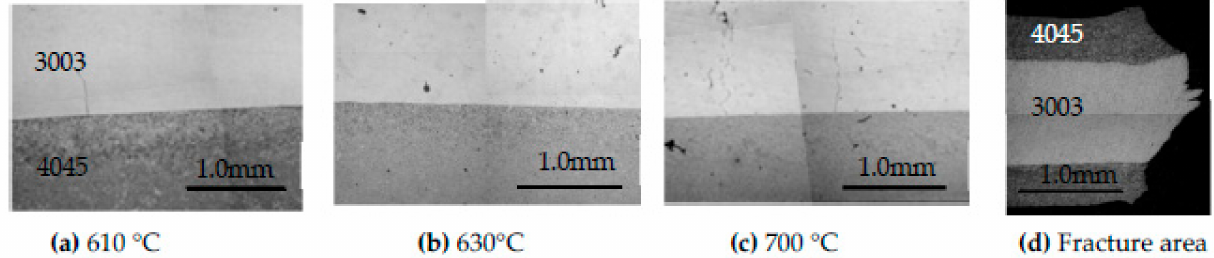
Figure 8. Cross-section near interface between base and overlay strips of as-cast strip, and fracture area after bending- fracture test of cold-rolled strip. Molten metal of overlay strip: ( a ) 610 ◦ C, ( b ) 670 ◦ C, ( c ) 700 ◦ C, ( d ) Fracture area of clad strip of ( a ) after cold-rolling and bending-fracture